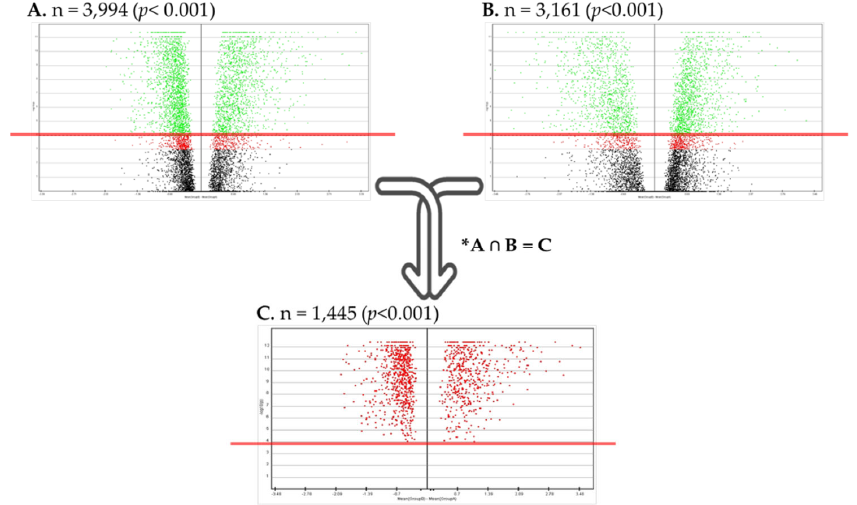
Figure 1. Volcano spots for screening differentially expressed mRNAs. Cut ‐ off point was − log 10( p ) > 3. ( A ) 526 breast cancer and 60 adjacent non ‐ cancerous breast tissues, ( B ) 60 breast cancer paired with 60 adjacent non ‐ cancerous breast tissues, ( C ) intersection of ( A , B ), * ( A ) ∩ ( B ) = ( C ); Intersection ( A , B ). The diagnostic performance of 1,445 selected DE mRNAs was determined using ROC curve analysis. 20 DE mRNAs ( p < 0.0001) with an area under the curve (AUC) value of 0.9 or higher were selected. Results for selected DE mRNAs are listed in Table 2. The mRNA with the highest AUC value was ING3 (0.96, 95% CI = 0.94–0.97), and the mRNA with the lowest AUC value was SPINT2 (0.90, 95% difference = 0.87–0.93).